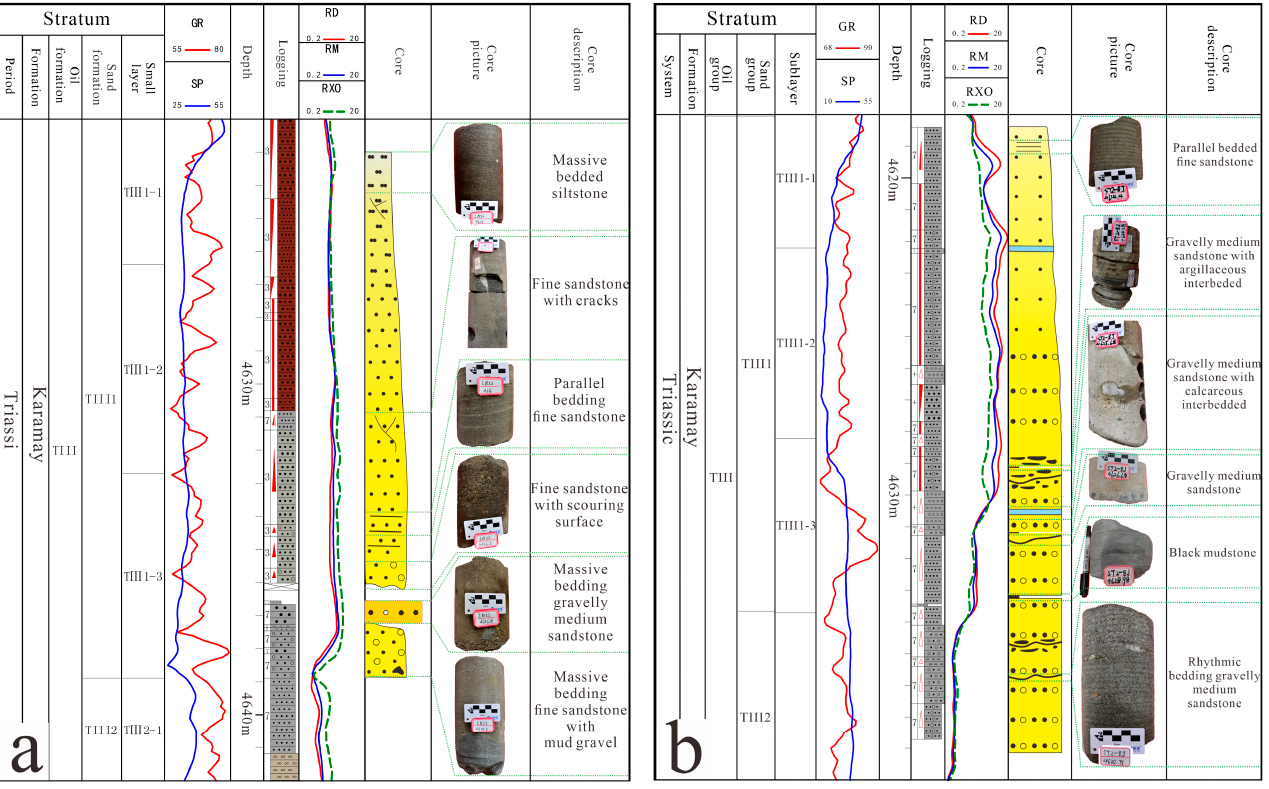
Figure 4. The vertical sequence in Sangtamu area (( a ) well LN22; ( b ) well ST2-8J).